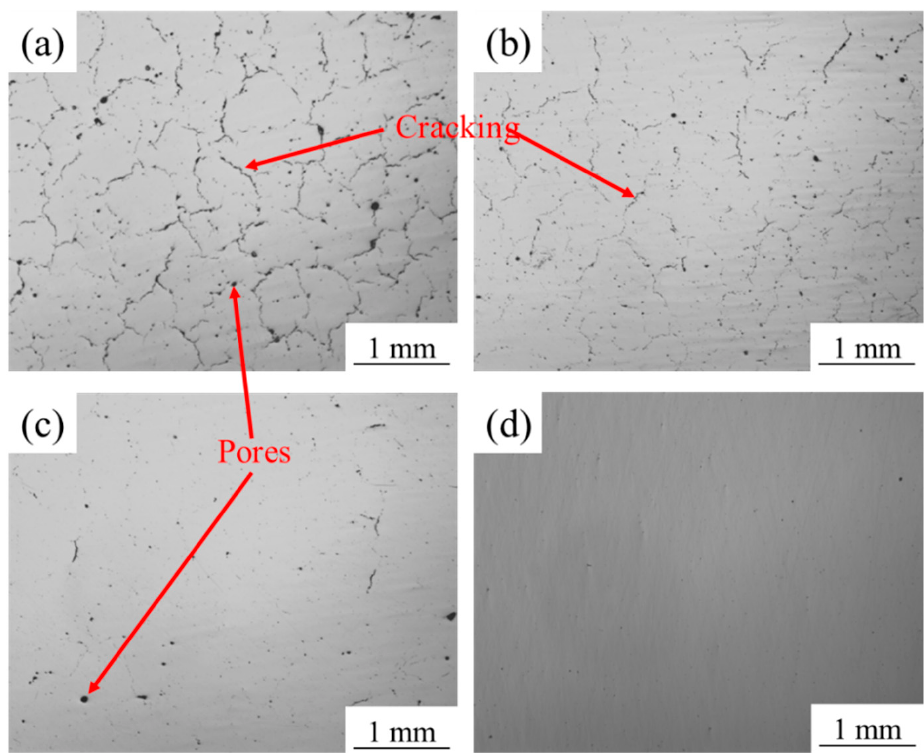
Figure 10. Horizontal microstructure morphology of Al-6.2Zn-2Mg-xSc-xZr alloy samples, ( a ) sample 1, ( b ) sample 2, ( c ) sample 3, ( d ) sample 4.